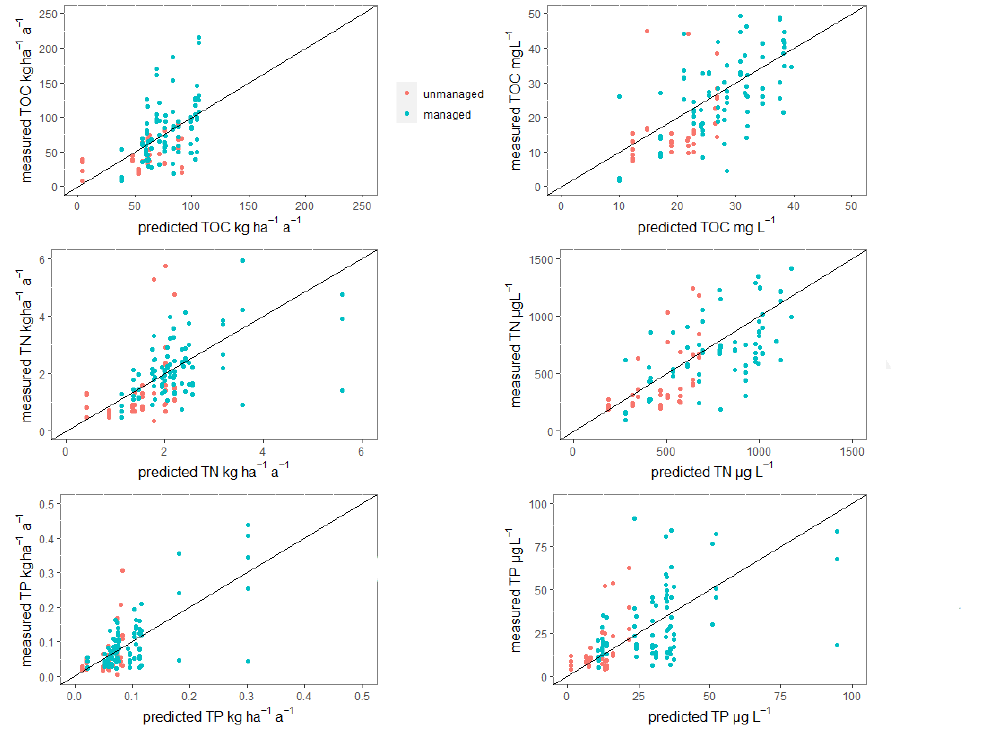
Figure 4. Goodness of fit of the model where predicted values are plotted against measured